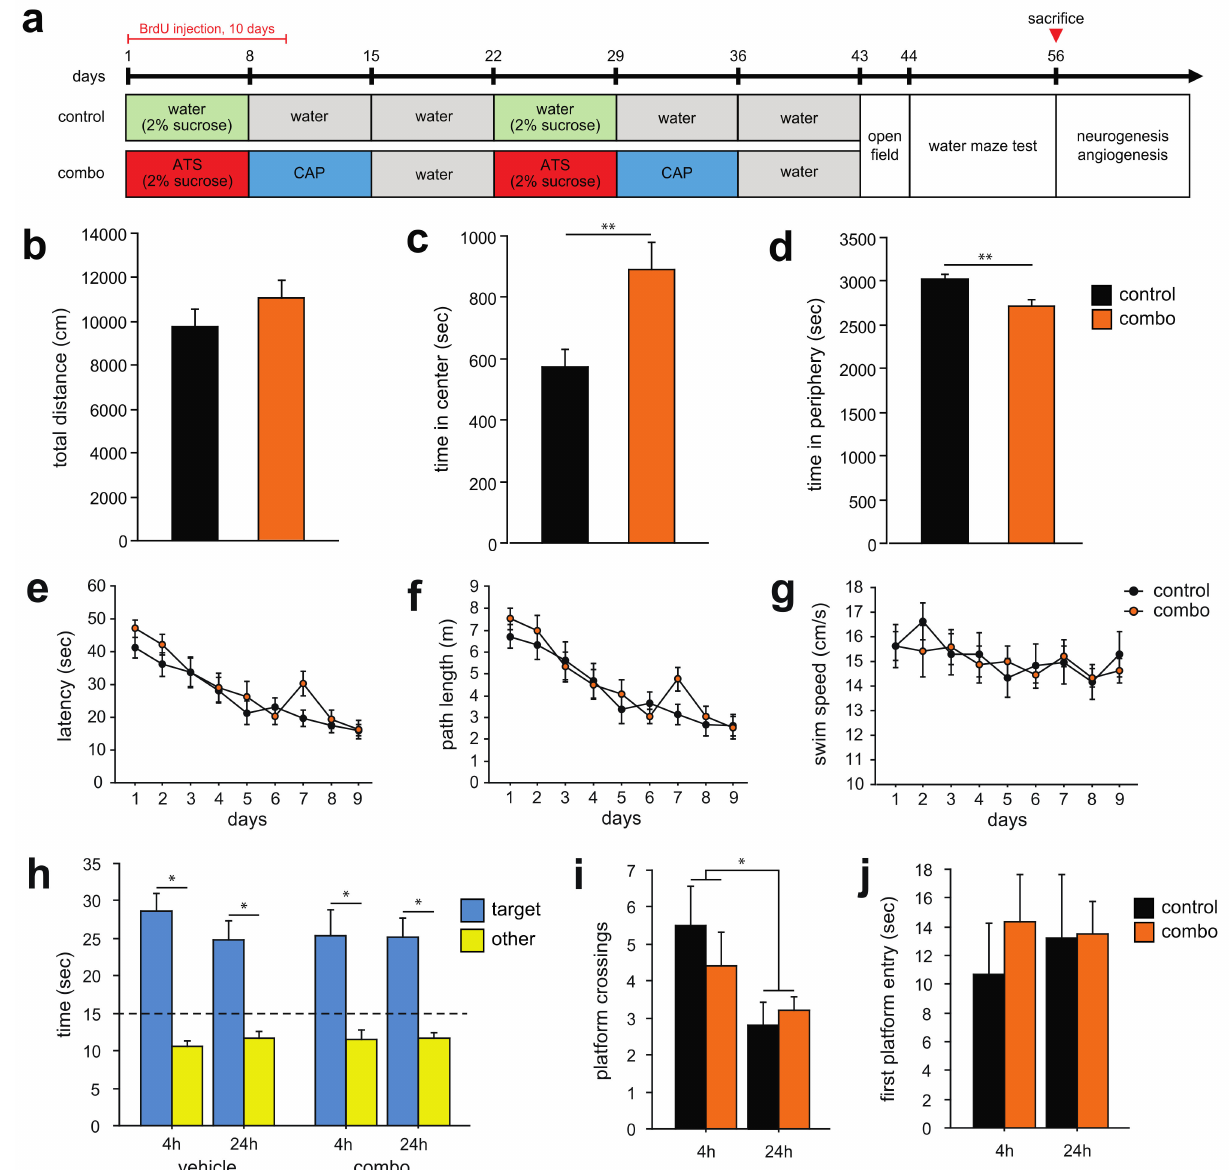
Figure 1. Effects of compound treatment on locomotion, anxiety and spatial memory in middle-aged mice. ( a ) Compound treatment and behavioral testing schedule in middle-aged mice. At the onset of the experiment, each compound was administered to mice daily for a week at a time for two cycles, a total of six weeks of treatment. ( b ) There was no difference in locomotor distance between the groups. ( c ) The combo group spent significantly more time in the center of the arena than the control group and ( d ) less time in the periphery, indicating that compound treatment reduces anxiety. ( e – j ) Mice were trained in the water maze with 4 trials a day for 9 days. There was no difference between the groups in ( e ) latency and ( f ) distance to the platform or ( g ) swim speed. ( h ) In the probe trials 4 and 24 h after the last acquisition session, both groups spent significantly more time in the target area than the other quadrants. ( i ) The number of platform crossings did not differ between the groups, however, both groups displayed less crossings in the 24 h as compared to 4 h probe trial. ( j ) Latency to the first platform crossing did not differ between the groups. Atorvastatin, ATS; captopril, CAP; bromodeoxyuridine, BrdU. * p < 0.05, ** p < 0.01. The dashed line in ( h ) represents chance level in the probe